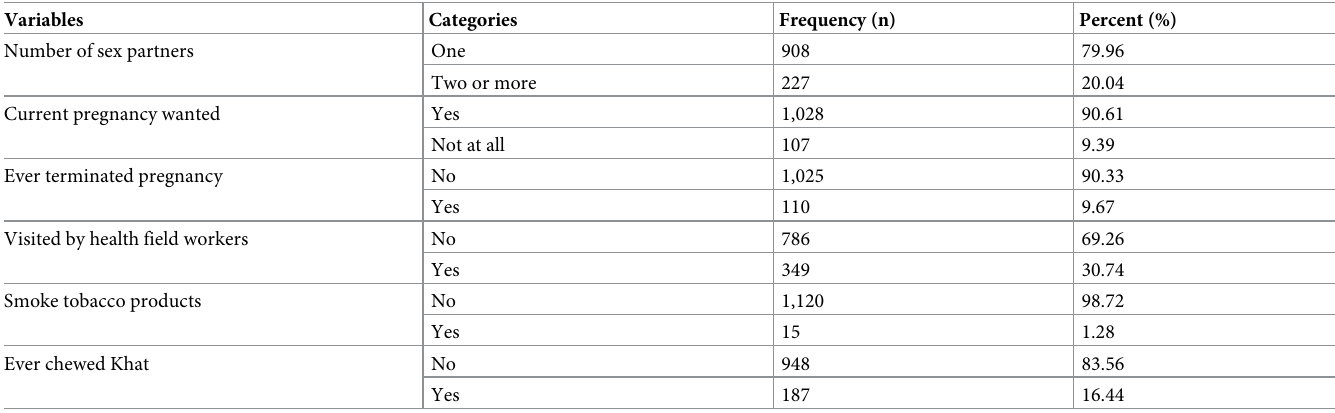
The estimated prevalence of alcohol consumption during the current pregnancy among preg- nant women in Ethiopia was 22.49% with a 95% CI of 18.18 to 26.17. It is varied across the regions of the country. The highest prevalence (73.21%) was observed in the Tigray region and the lowest (0%) in Somali ( Fig 1 ).